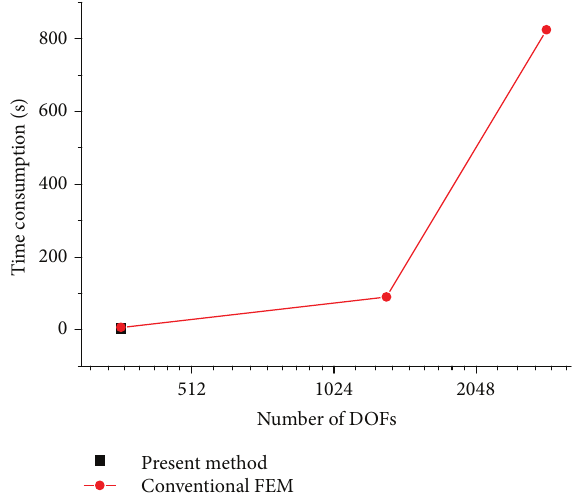
Figure 10: Time consumption comparison of center deflection for the clamp supported Mindlin plate under uniform load stochastic analysis.